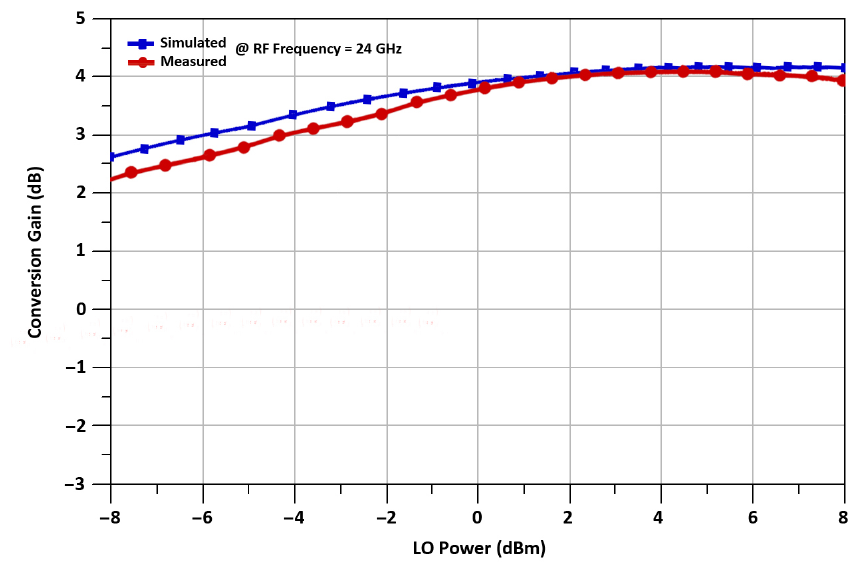
Figure 19. Conversion gain vs. LO power of the mixer.